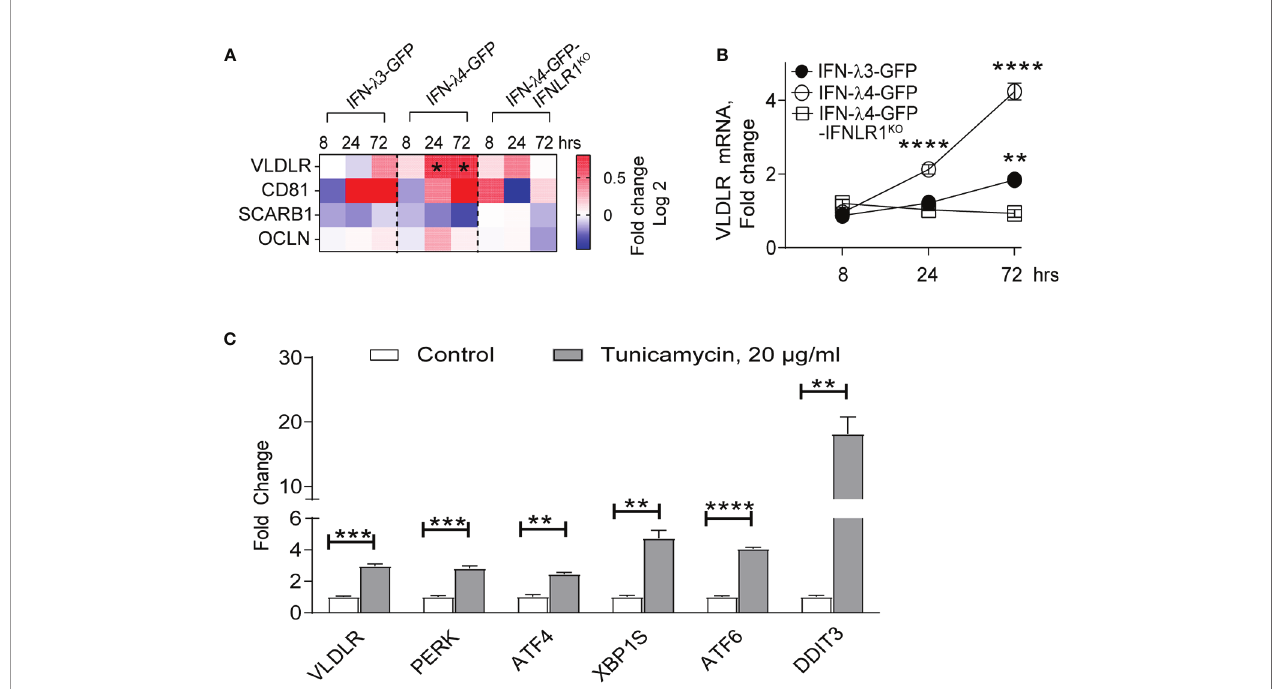
FIGURE 4 | IFN- l 4 upregulates VLDLR expression. (A) Differential expression of HCV receptors identi fi ed by RNA-seq analysis ( Table S1 ) comparing corresponding dox+ and dox- HepG2 cells induced for indicated times points and presented as fold change (Log2). * represents signi fi cant (p<0.05) induction above 1.5 fold. (B) qRT-PCR analysis of VLDLR after IFN- l 4 induction in corresponding HepG2 cells. Mean +/- SEM (C) qRT-PCR analysis of VLDLR , as well as select UPR-associated genes in HepG2 cells following tunicamycin treatment for 24 hours. Each gene expression was normalized by the expression of endogenous controls ( GAPDH and ACTB ) and by expression in corresponding untreated groups. ** P < 0.01, *** P < 0.001, **** P < 0.0001, Student ’ s